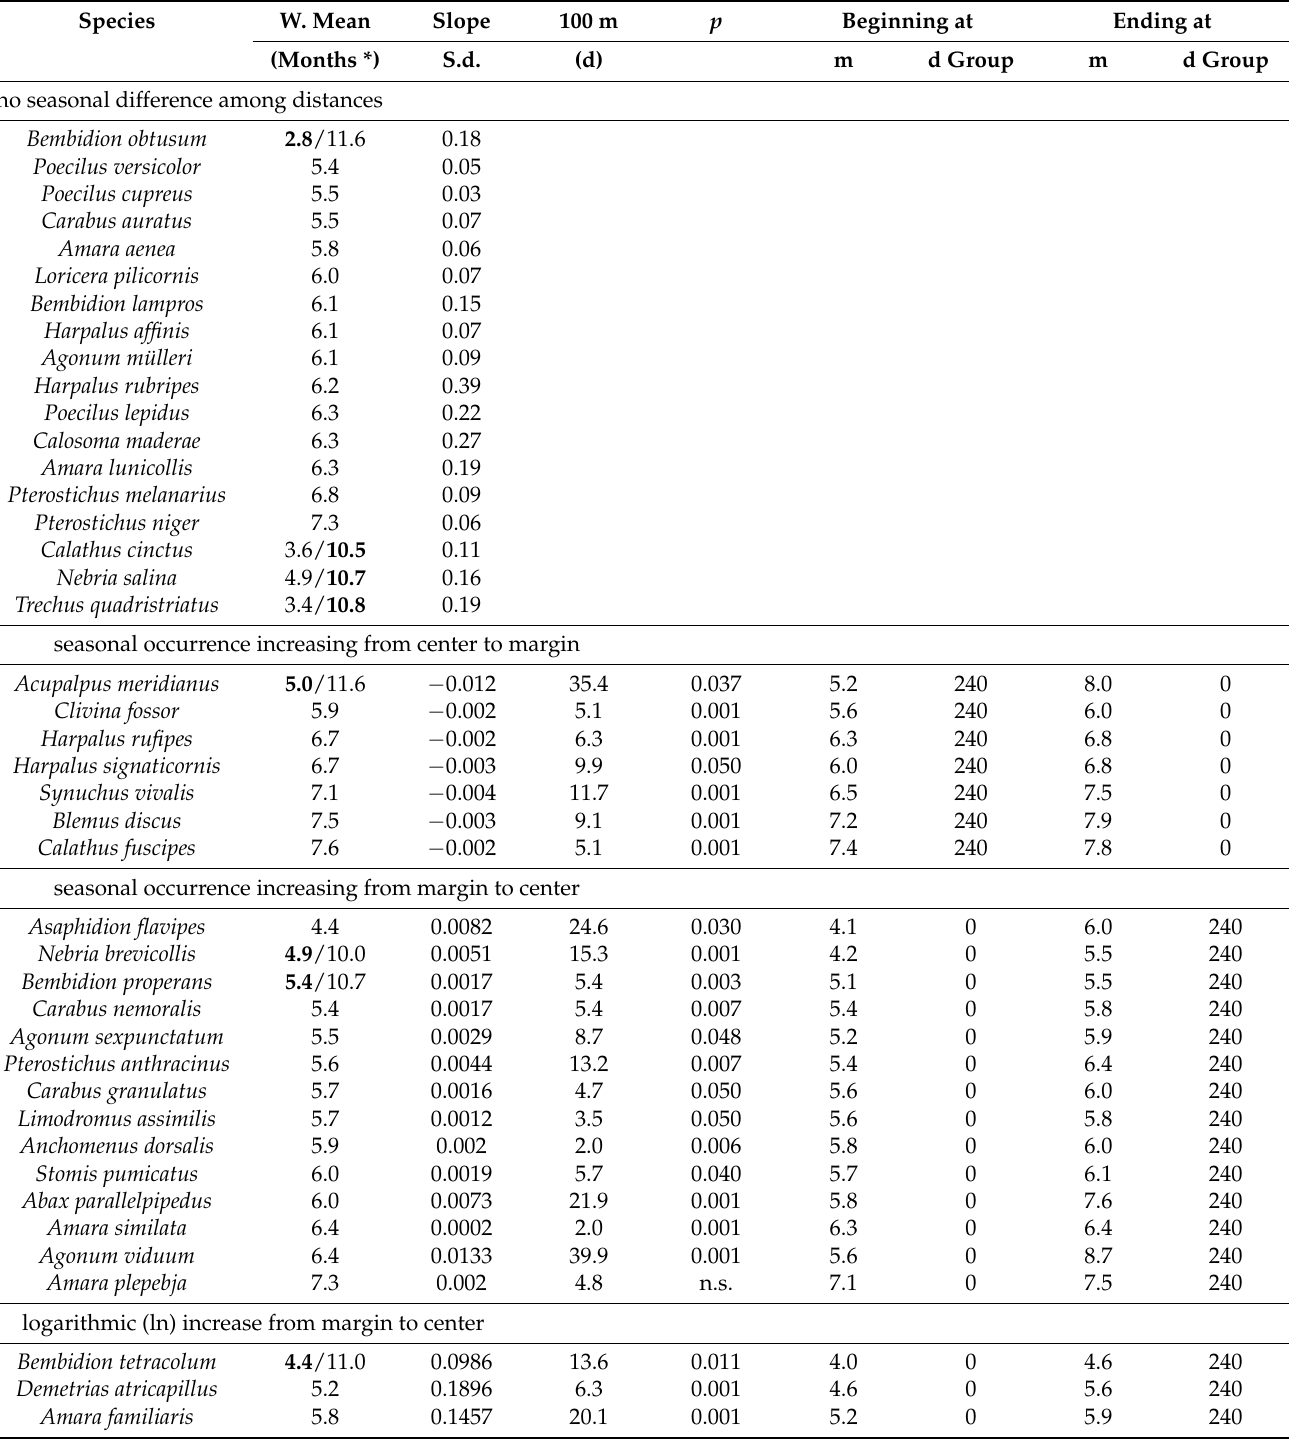
Table 1. Indicators of seasonality for selected species. W. mean: weighted mean of months with activity; for species with two distinct peaks of activity per year, both peaks are listed separately (bold type notes the major peak); Slope: slope for species with gradient w. mean in the margin—field gradient; s.d.: standard error for species without different change in w. mean in the distance gradient; 100 m (d): calculated speed of immigration with respect to emigration; p : probability error